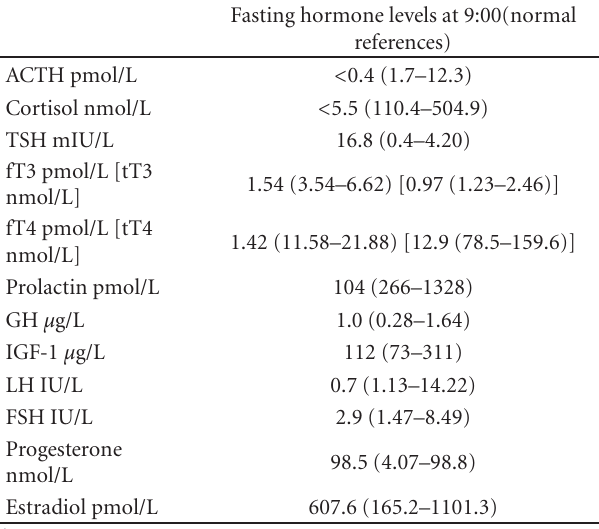
Table 2: Fasting blood hormone levels at 9:00 (6 months post partum) ∗